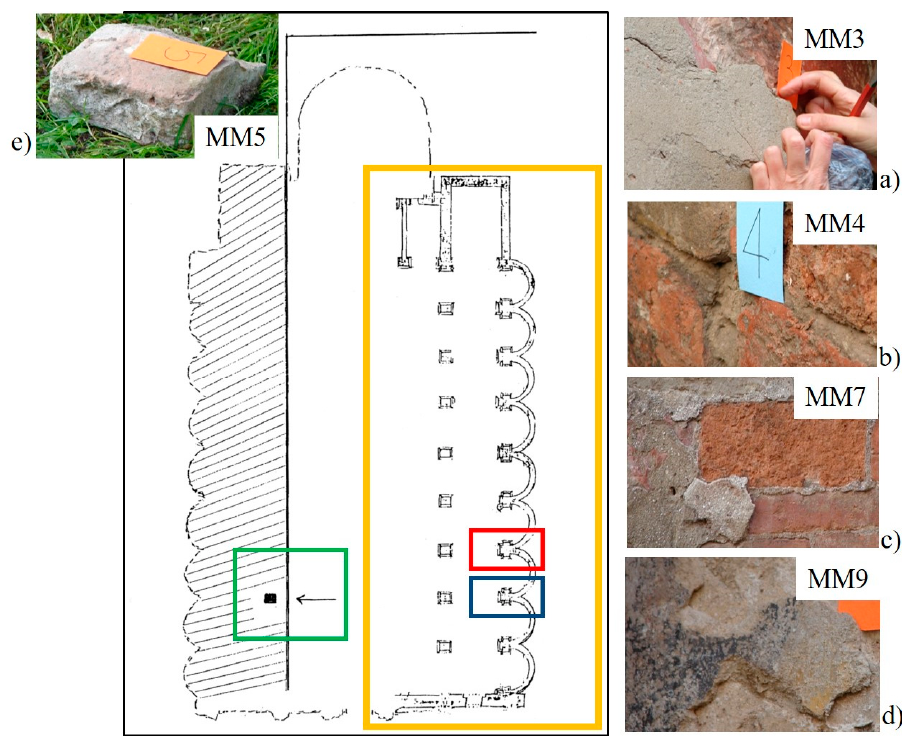
Figure 3. Map of the church of San Andrea and the sampling points; colored in red the column from which the samples MM3 and MM4 were collected; colored in blue the column from which the plaster samples MM7 − MM9 were collected; colored in green the dot that recalls the exact place of Biagio Rossetti’s burial. In detail: ( a ) plaster MM3; ( b ) brick MM4; ( c ) plaster MM7; ( d ) plaster MM9; ( e ) brick MM5. Table 1. List of samples collected and analyzed specifying the type of sample: R represents the samples from Palazzo Roverella, C: samples from Santa Maria delle Grazie and MM: samples from San Antonio. Samples